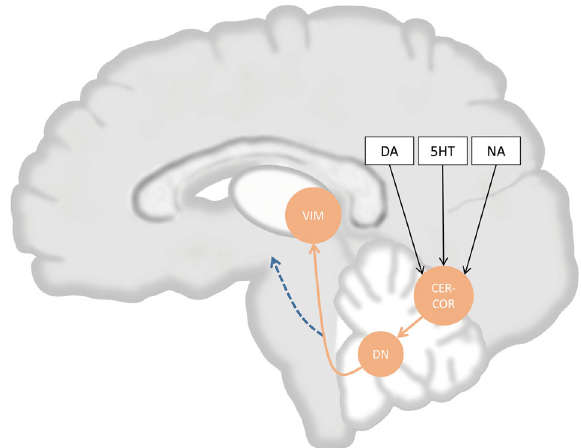
Fig. 2 Neurotransmitters modulate tremor activity in Parkinson ’ s disease (PD) via in fl uencing cerebellar output. Various neuro- transmitters including dopamine (DA), serotonin (5HT), and nora- drenaline (NA), affect the cerebellar cortex (CER-COR), which modulate the output activity of dentate nuclei (DN). DN project to ventral intermediate nucleus of the thalamus (VIM) and modulate tremor activity. Orange arrows indicate projections between CER- COR, DN, and VIM. The Blue arrows indicate cerebellar output to other brain regions. Black arrows indicate the effect of